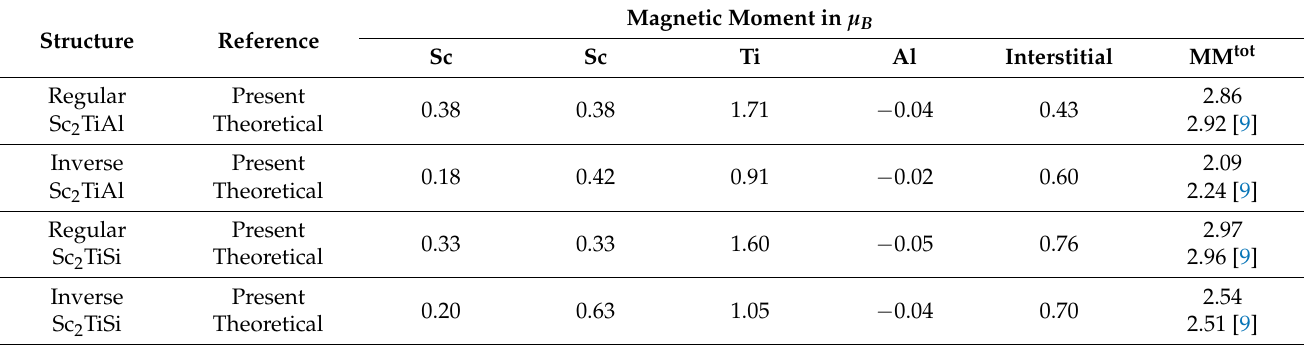
Table 2. Total, atom-resolved, and interstitial spin magnetic moments for inverse and regular Sc 2 TiAl and Sc 2